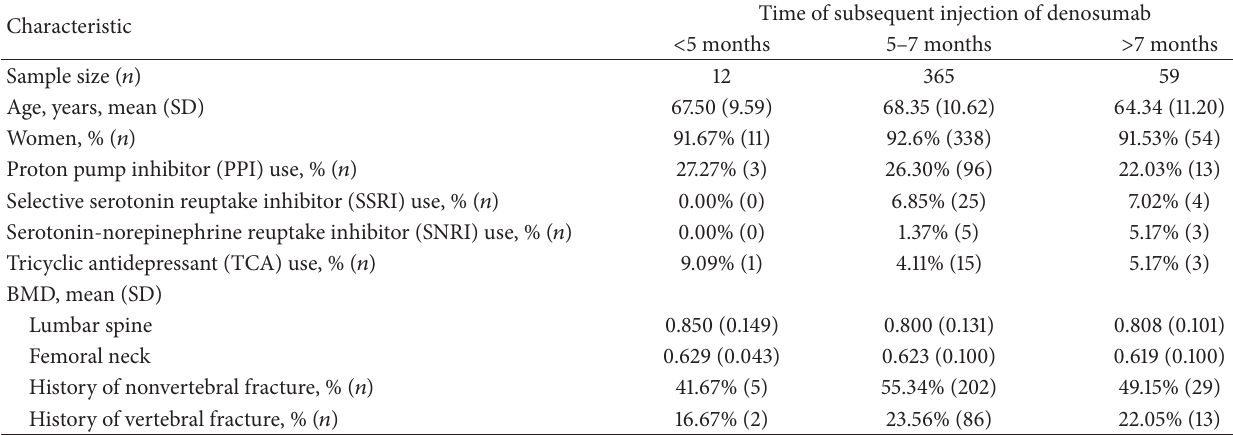
Table 1: Participant baseline characteristics stratified by time of denosumab injection.